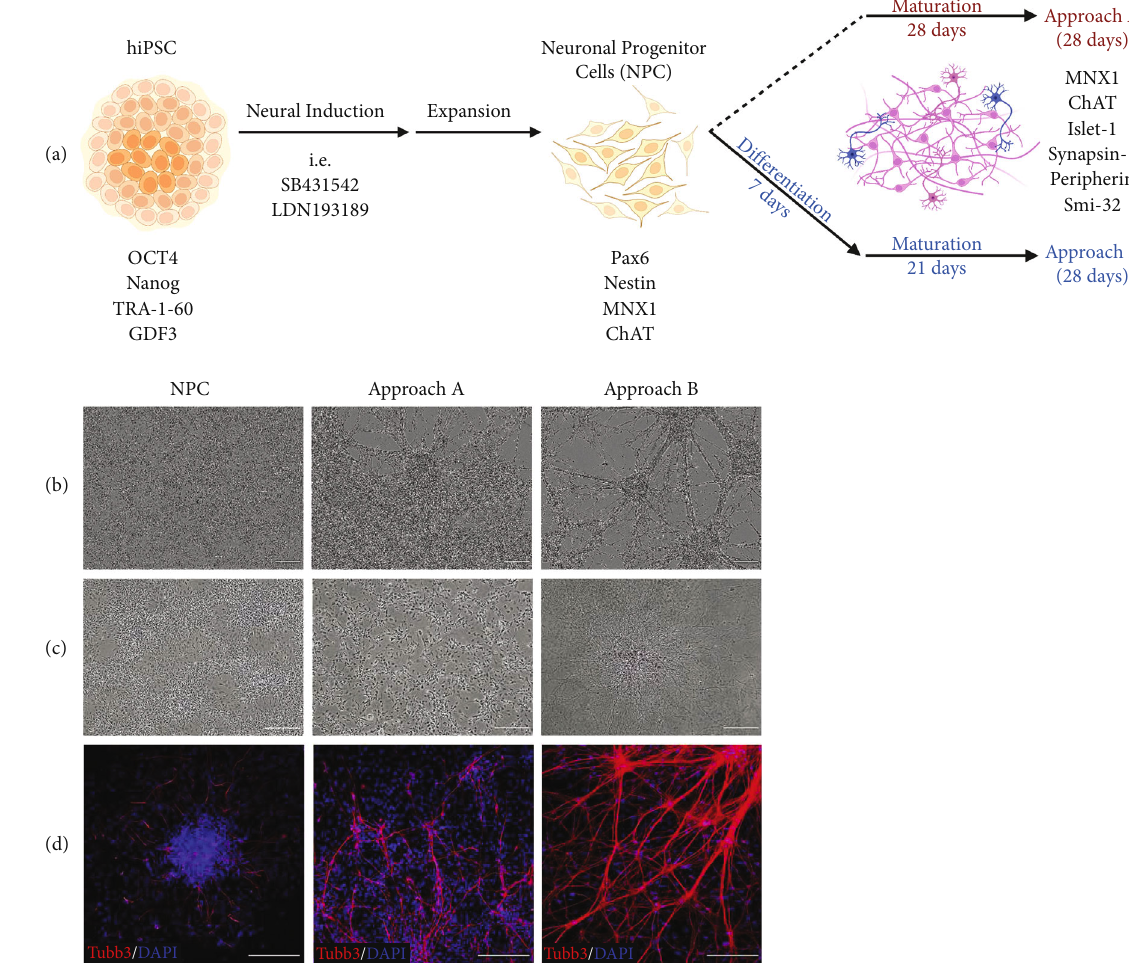
Figure 2: Morphological characteristics of neurons generated via approaches A and B compared to NPC. (a) A schematic overview of approaches A and B di ff erentiating hiPSC-derived NPC into MNs, created with http://BioRender.com. (b) Representative images of cells of approach A and B captured with the IncuCyte® showing MN-type clusters evolving from homogeneous NPC culture. (c) Neuronal identity was con fi rmed for both approaches via Bielschowsky silver staining, illustrated by brown-stained nuclei and axons. (d) Immuno fl uorescent staining for Tubb3 (beta-3-tubulin; red) revealed pronounced neuronal network formation via both approaches. Cell nuclei were counterstained with DAPI. All scale bars, 200 μ